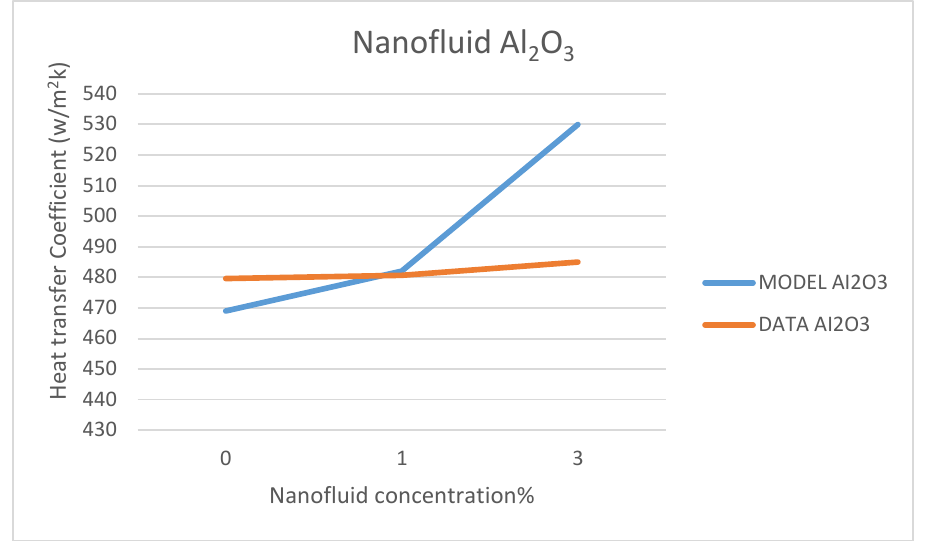
Figure 34. Comparison between model and data of Marefatoi et al. [31] for Al 2 O 3 as in text is (Al 2 O 3 ) and applies to all other Figures.